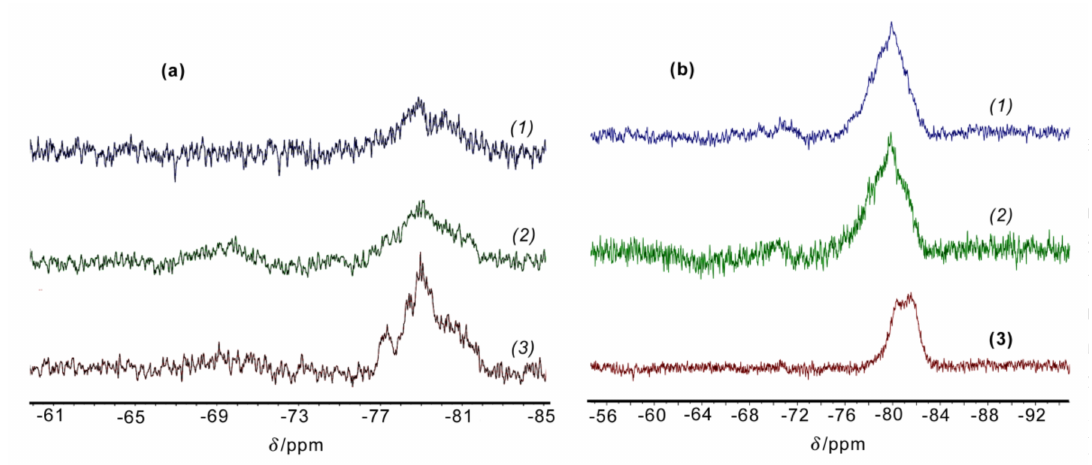
Figure 7. 29 Si nuclear magnetic resonance (NMR) spectra: ( a ) ( 1 ) of product 3.2 , ( 2 ) of 4 , and ( 3 ) of 5 ; and ( b ) ( 1 ), ( 2 ), and ( 3 ) of polymers 8 , 9 , and 10 ,